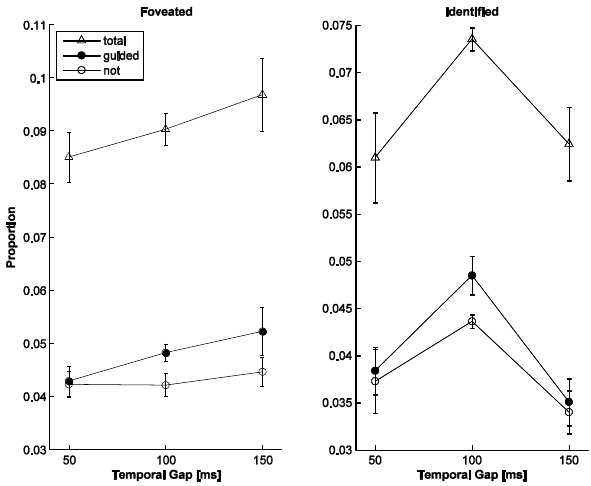
Figure 6. Letter foveation and identification rate for three different temporal gaps between marker offset and letter onset for the fixed-amplitude marker (50% guidance). Left: Proportion of foveated letters (total, guided, not-guided). Right: Proportion of identified